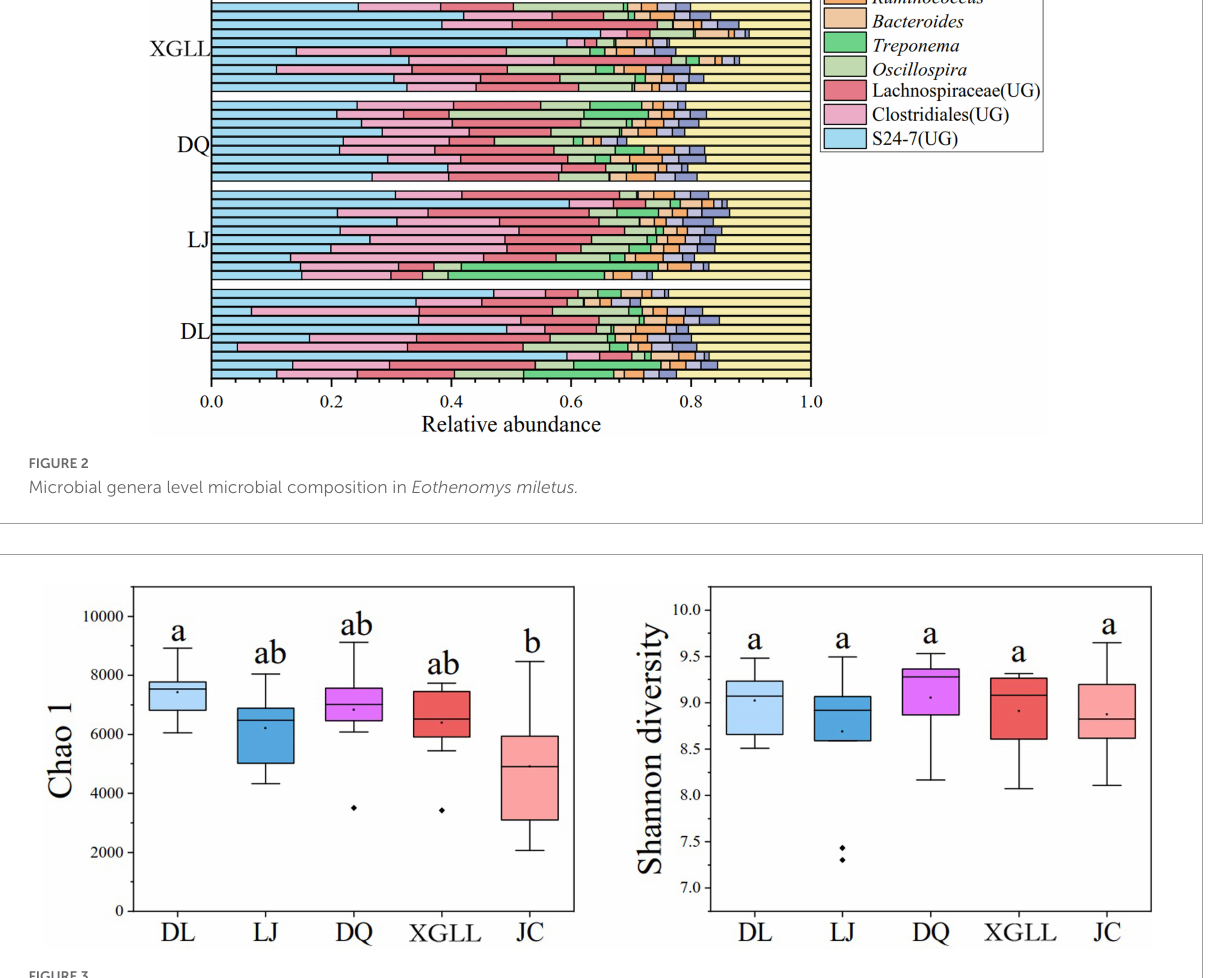
FIGURE3 α diversity of feces in Eothenomys miletus in different